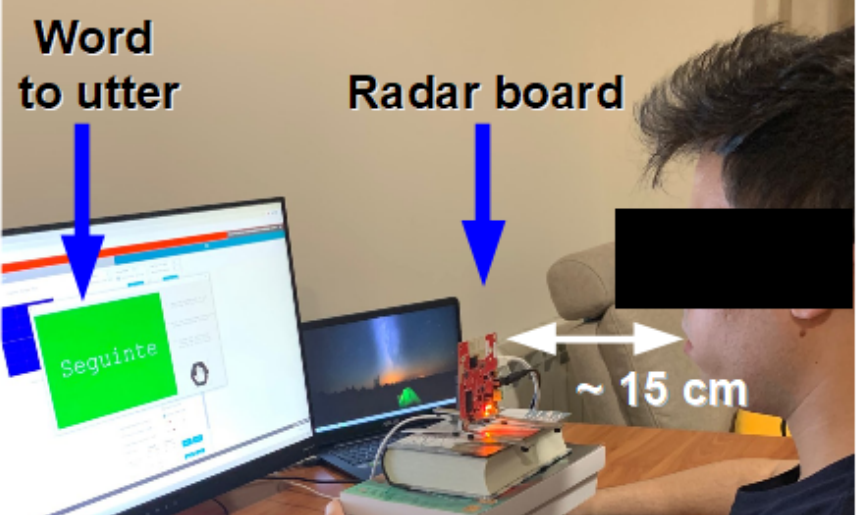
Figure 2. Radar setup for the data acquisition sessions. The participant is seated in front of the radar board while a monitor continuously displays the words to be uttered, turning the background green whenever the participant is asked to